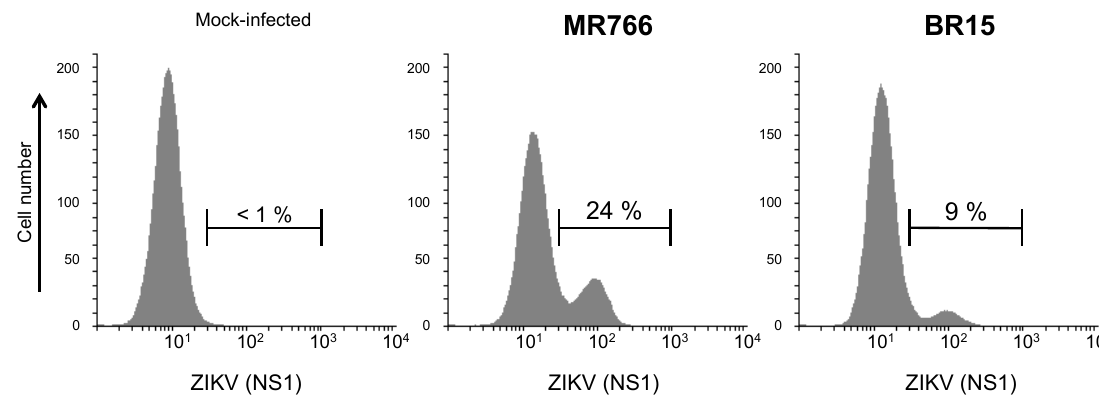
Figure 8. Reactivity of rat anti-rNS1 immune serum against NS1 produced in human epithelial cells infected by ZIKV. A549 cells were infected for 24 h with ZIKV strains MR766 and BR15 or mock-infected (no virus). Fixed cells were permeabilized and incubated with rat anti-rNS1 immune serum at dilution 1:1000 as primary antibody. The percentages of ZIKV-infected A549 cells positively stained with anti-rNS1 immune serum were determined by flow cytometry analysis, and the values are indicated on the top.